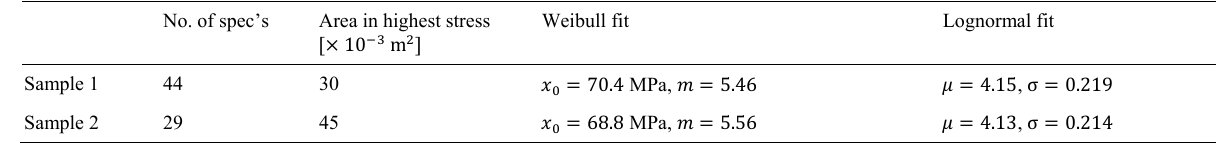
Table 2: Model Parameter Estimates